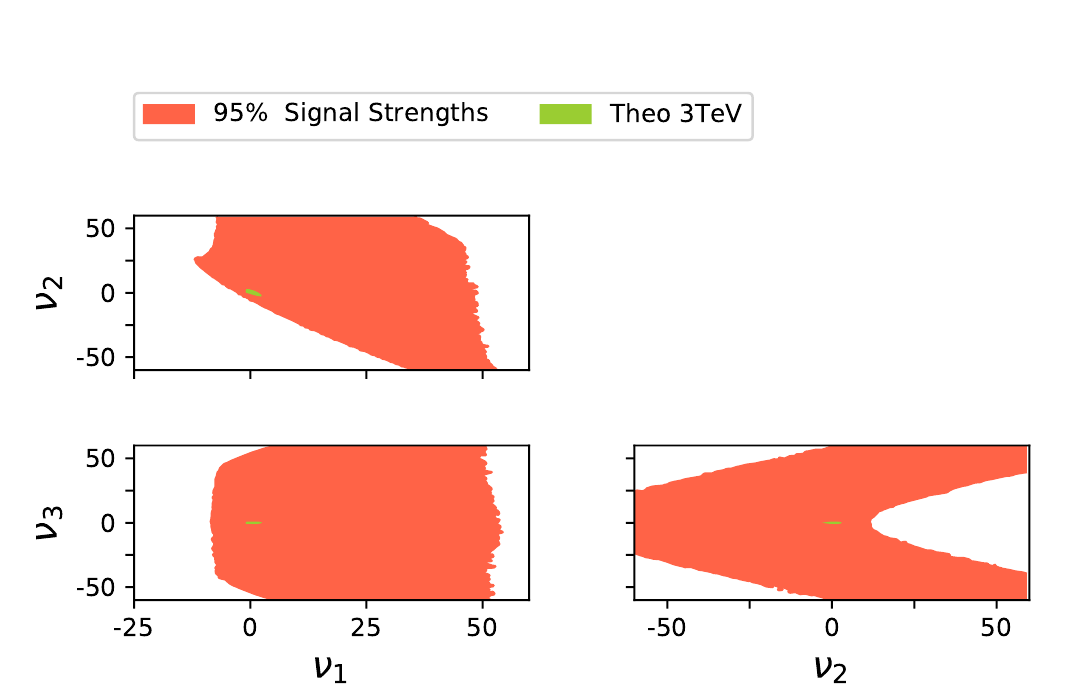
Figure 2 . Two-dimensional constraints on ν 1 , ν 2 and ν 3 from Higgs signal strengths (red), compared with the theoretically allowed regions (green), assuming RG stability up to 3